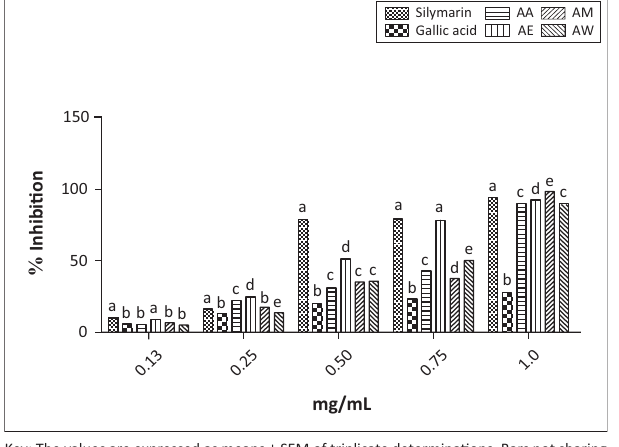
FIGURE 3: Total antioxidant capacity by phosphomolybdenum of Acalypha godseffiana (leaves).